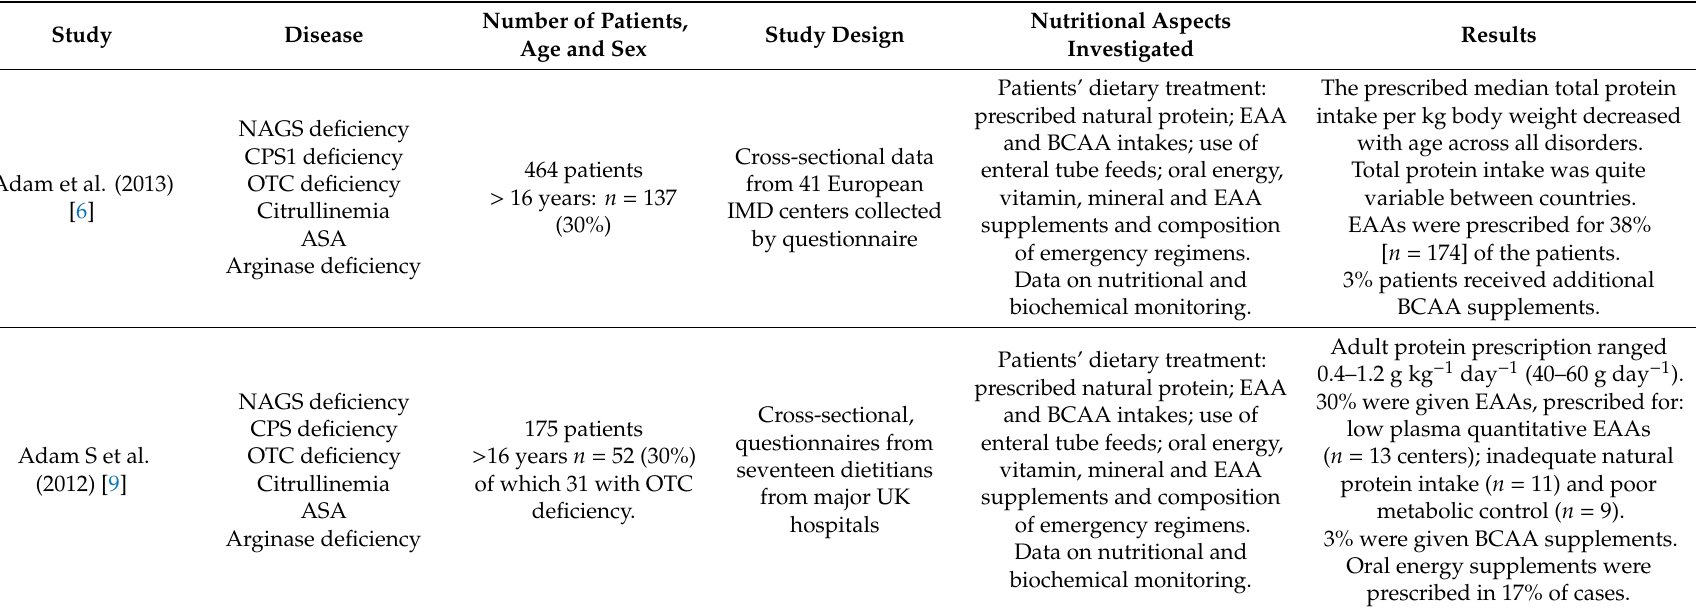
Table 1. Summary of studies investigating the nutrient intake and nutritional status in patients with branched chain organic acidurias and urea cycle disorders treated with low protein